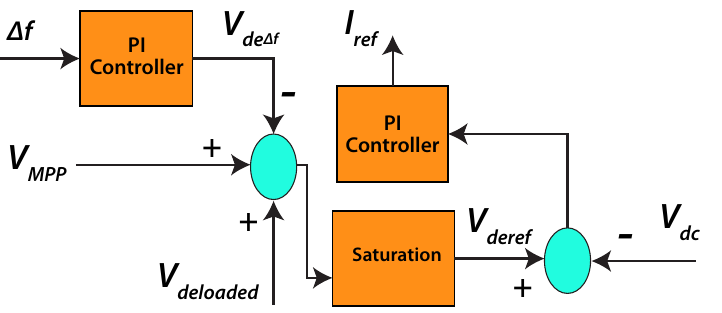
Figure 13. De-loading technique for PV system.